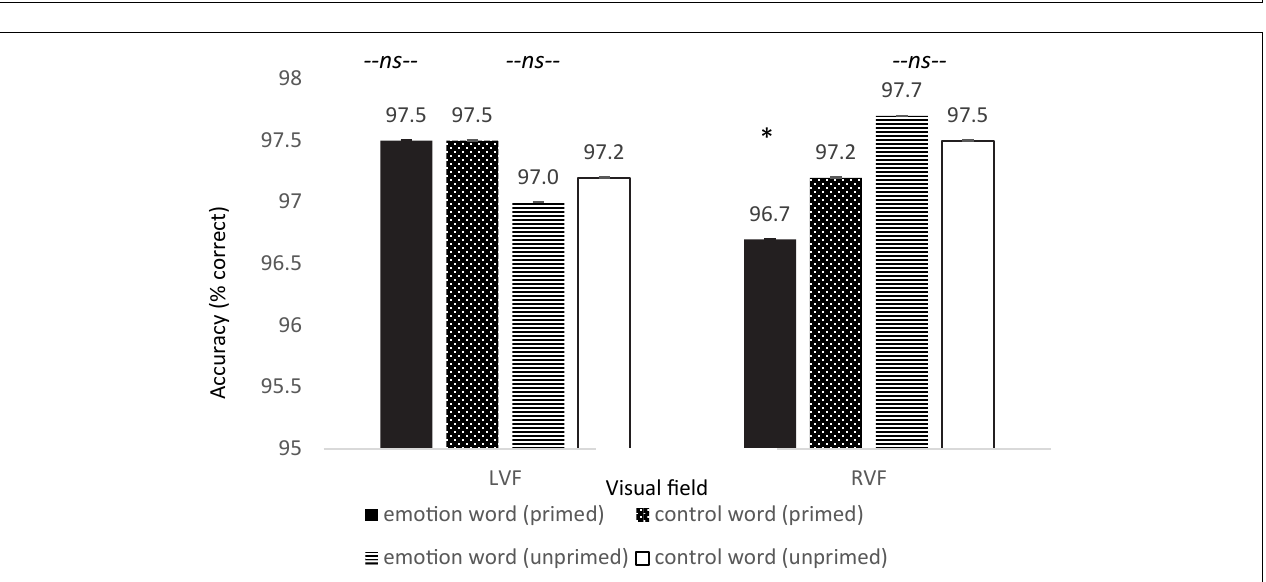
FIGURE 4 | Reaction time differences between pair types by visual field for Experiment 2. There was a significant effect for the primed trials but only in the RVF (left-hemisphere) between emotion words and control words, in line with the hypothesis that participants would be slower to respond due to elaborative linguistic processing to trials preceded by an emotion word that is able to be integrated with the face.